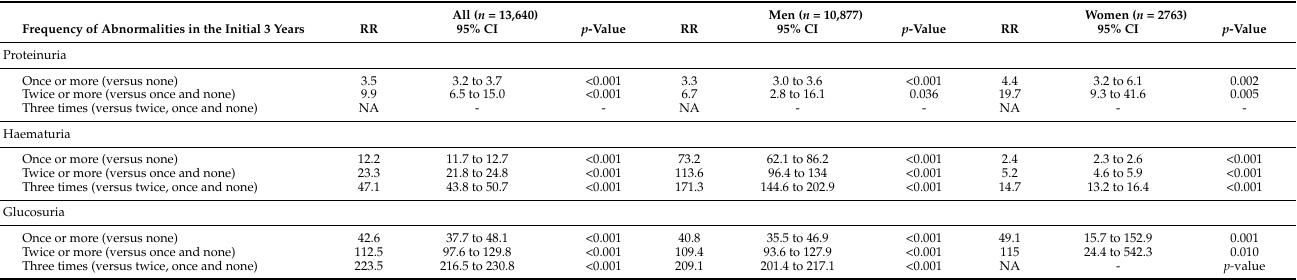
Table 3. Associations between prevalence of urinary abnormalities in the fourth year and their frequency in the initial 3 years. All( n